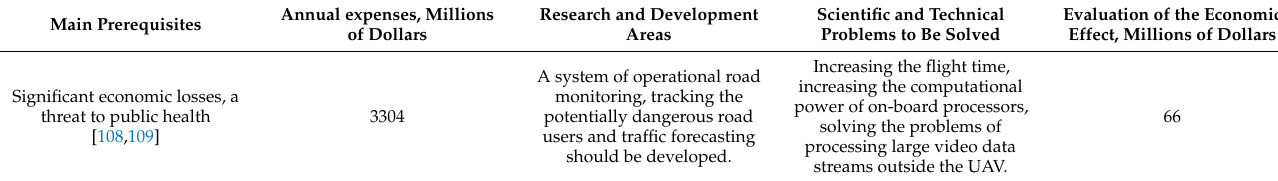
Table A8. IUAVT use for traffic monitoring